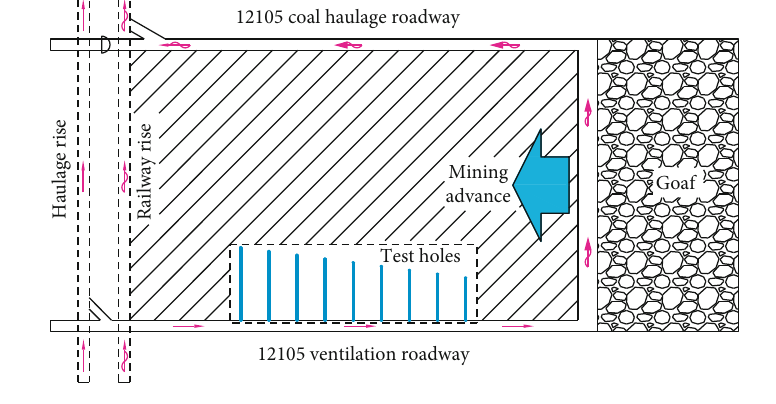
Figure 5: Layout pro fi le of boreholes.